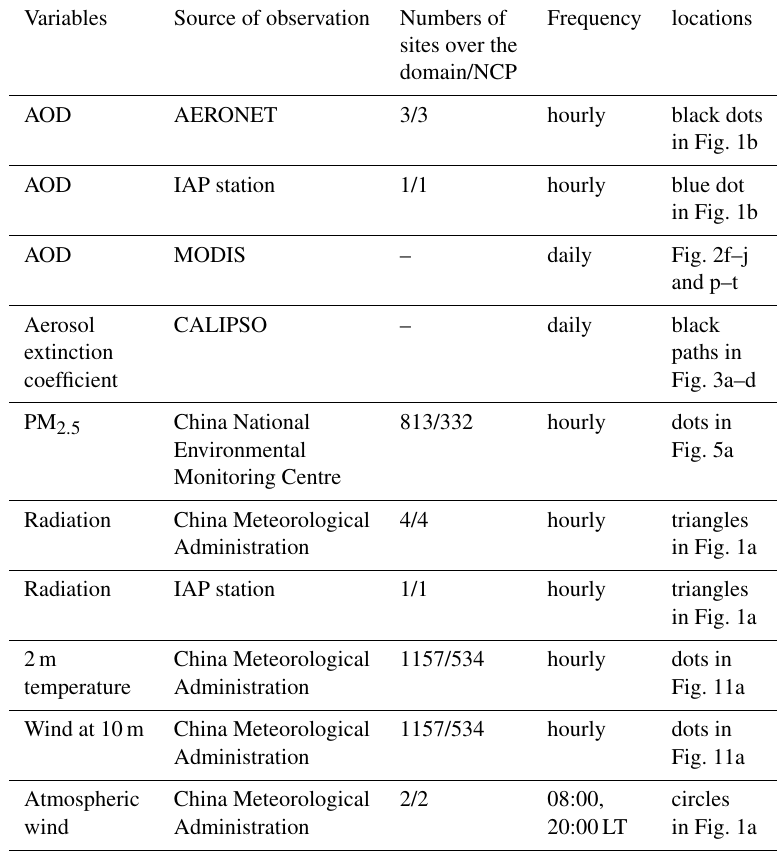
Table 1. The variables, sources, numbers of sites in the domain and the NCP, and the frequency of chemical and meteorological observations. Variables Source of